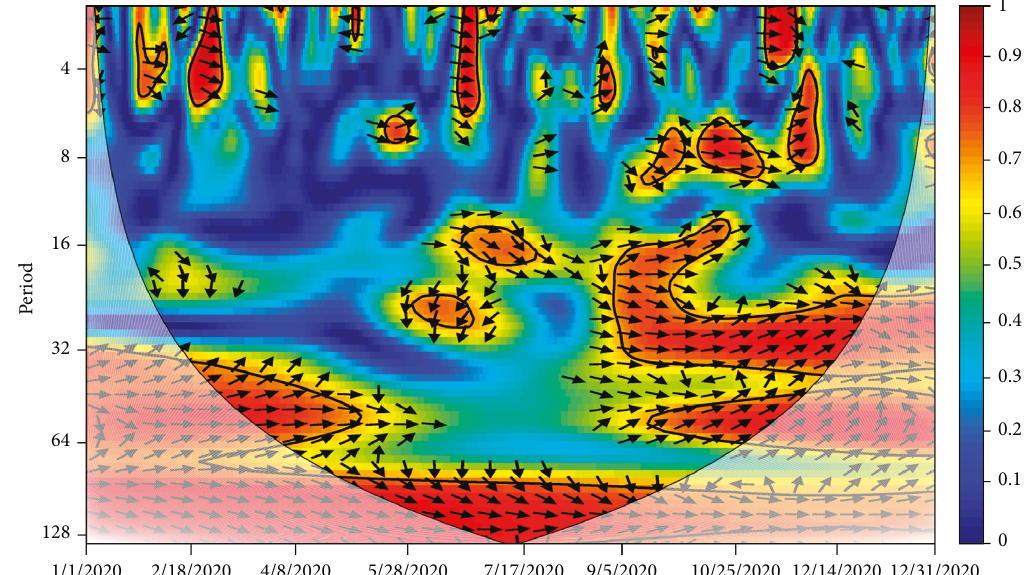
Figure 7: The wavelet coherency between illiquidity and VIX (pandemic period). Note: this figure reports the wavelet coherency between illiquidity and VIX during pandemic period. The black contour represents the regions in which the spectrum is significant at the 5% level against red noise. The cone of influence denoted as COI is designated by the lighter shade which delineates the high power regions. Time and scale (days) are represented on the horizontal and vertical axes, respectively. Arrows pointed to the right (resp. left) signify that the variables are in phase (out of phase). If arrows move to the right and up (resp. down), the first variable is the driver (resp. follower). By contrast, if arrows move to the left and up (down), the second variable is leading (resp.